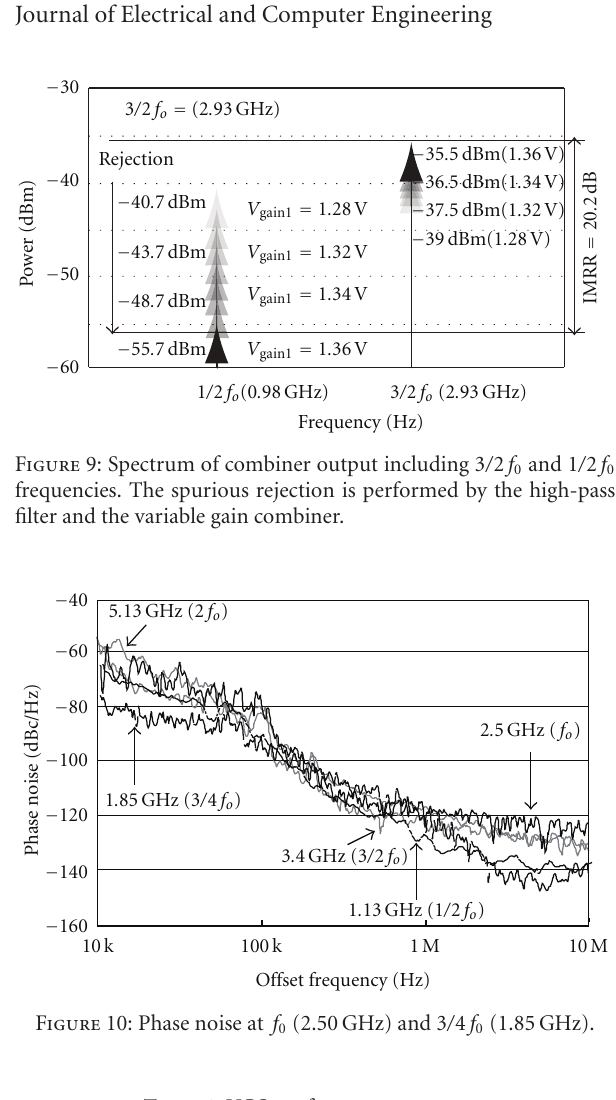
Table 1: VCO performance summary.